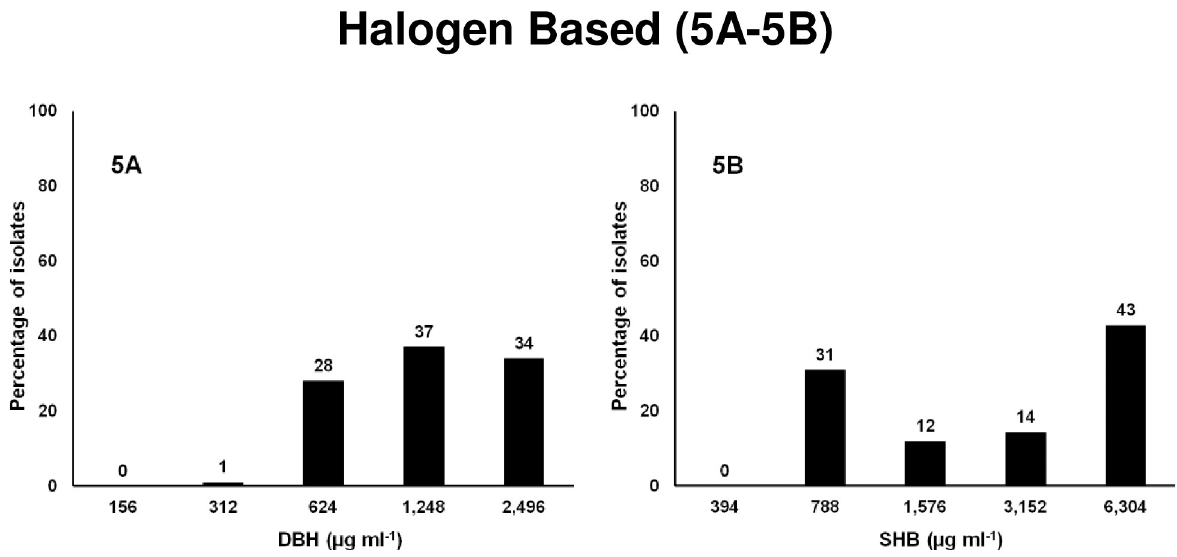
Fig 5. Frequencies of the MICs of 88 MDR Salmonella isolates to halogen based compounds. X-axis is the 2-fold increase of biocide concentration; y-axis is percentage of isolates susceptible at each concentration. 5A. 1,3 dibromo, 5,5 dimethylhydantoin, DBH and 5B. Sodium hypochlorite,